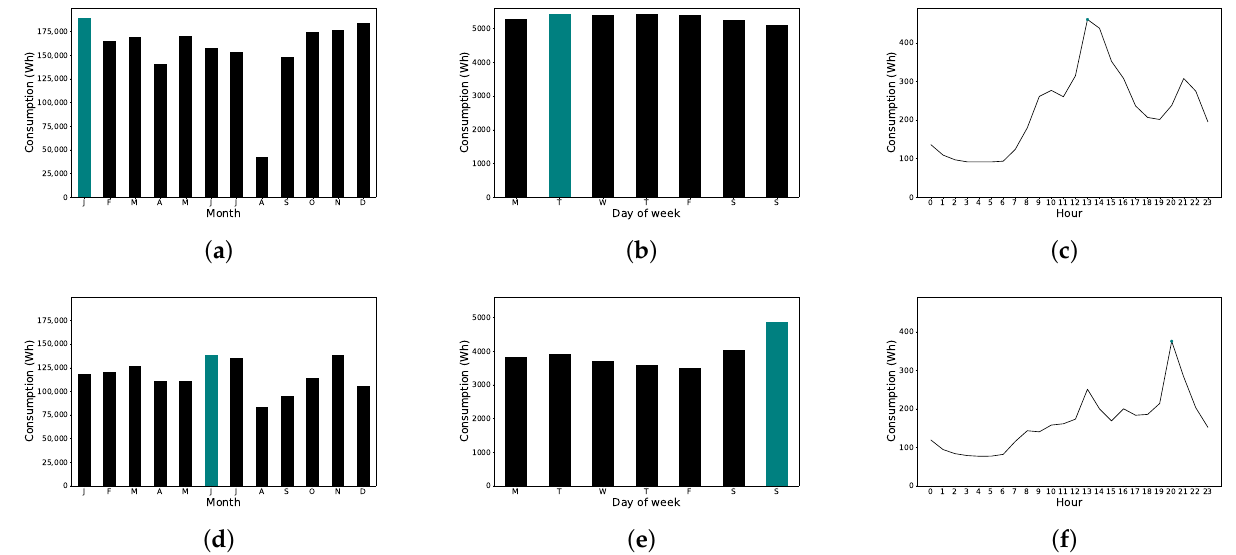
Figure 2. Consumption of households ( a ) H1 and ( b ) H2. Figure 3 shows the power consumption of H1 and H2, the total consumption of the month, the total consumption of each day of the week, and the hourly consumption of a day. In these figures, the month, day of the week, and time of day with the highest consumption are shown in blue coloring.